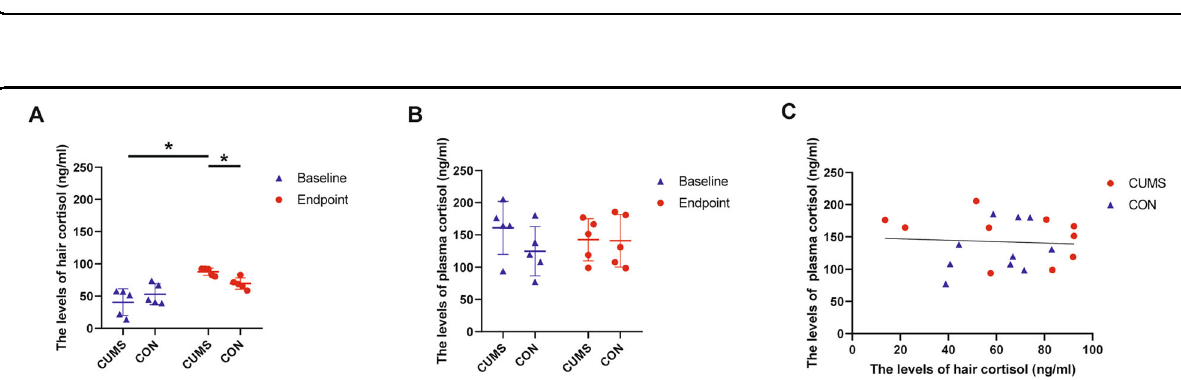
Fig. 3 The results of attempt for apple test (AAT) and human intruder test (HIT) in CUMS and CON groups. A The schematic of the AAT. B The duration of attempts for apple for total three days. C The frequency of attempts for apple for total three days. D The schematic of the HIT. E The duration of the anxiety-like behaviors in each phase. F The total duration of the anxiety-like behaviors in four phases. * P < 0.05. Subject S2 in CUMS group dropped out of AAT and HIT due to diarrhea, so we imputed the median value for each behavior in CUMS group as the value of S2 in statistical analysis.